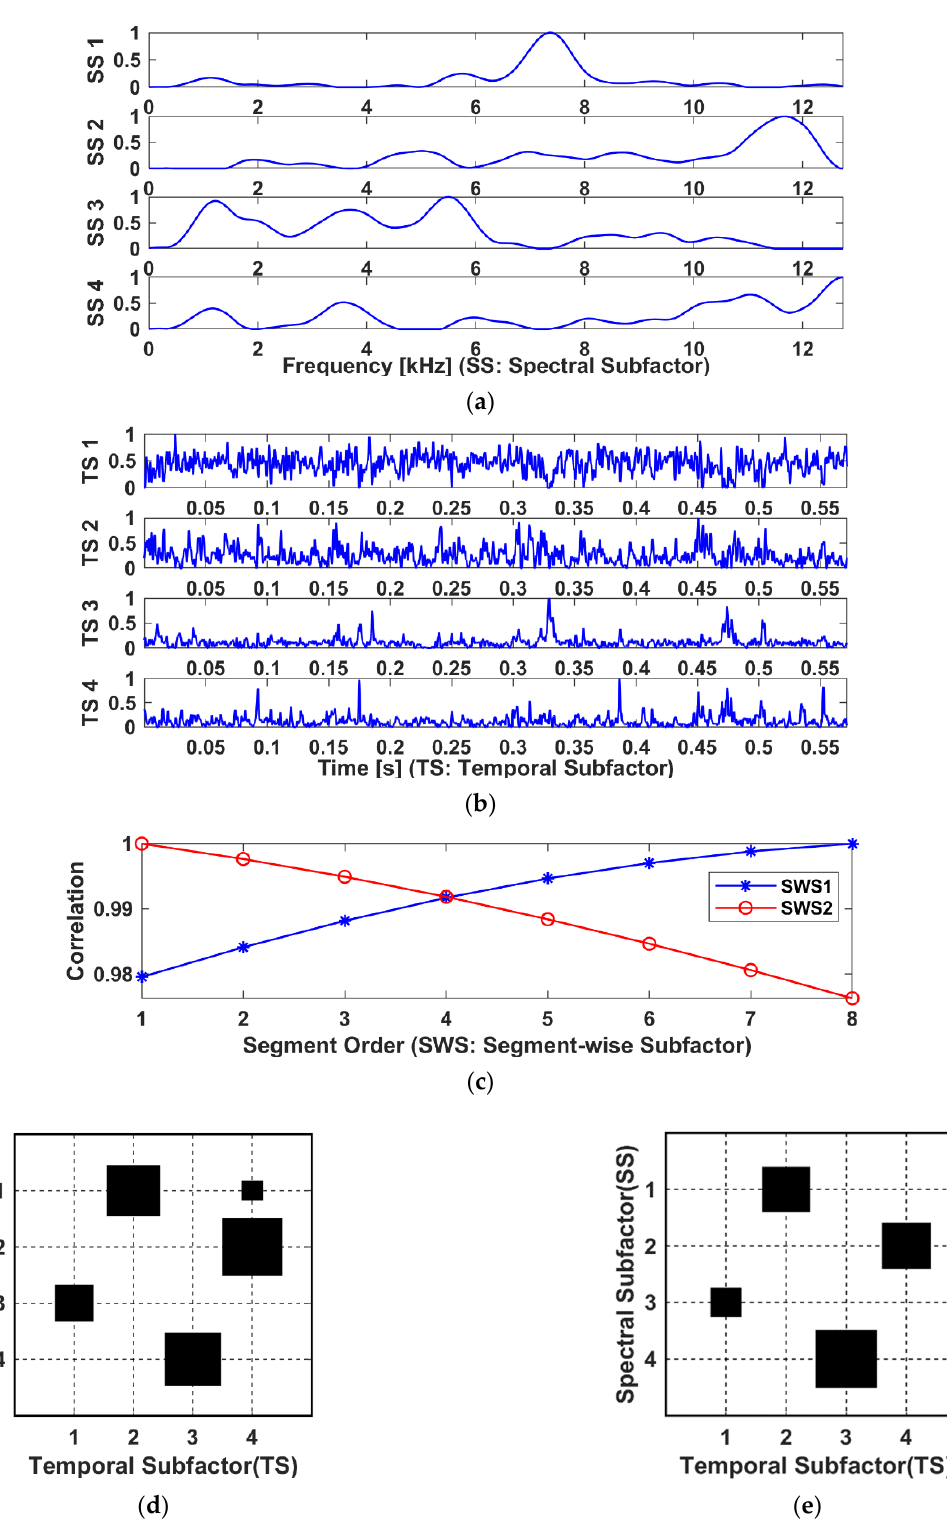
Figure 7. Factors of LRANTD: ( a ) the Spectral Factor, ( b ) the Temporal Factor, consisting of 4 temporal subfactors with kurtosis of 2.98, 4.1, 15.7, and 13.3, respectively, ( c ) the Segment-wise Factor with 2 subfactors, and ( d ) the Core Tensor represented via its frontal slice w.r.t. SWS1, and ( e ) that w.r.t.